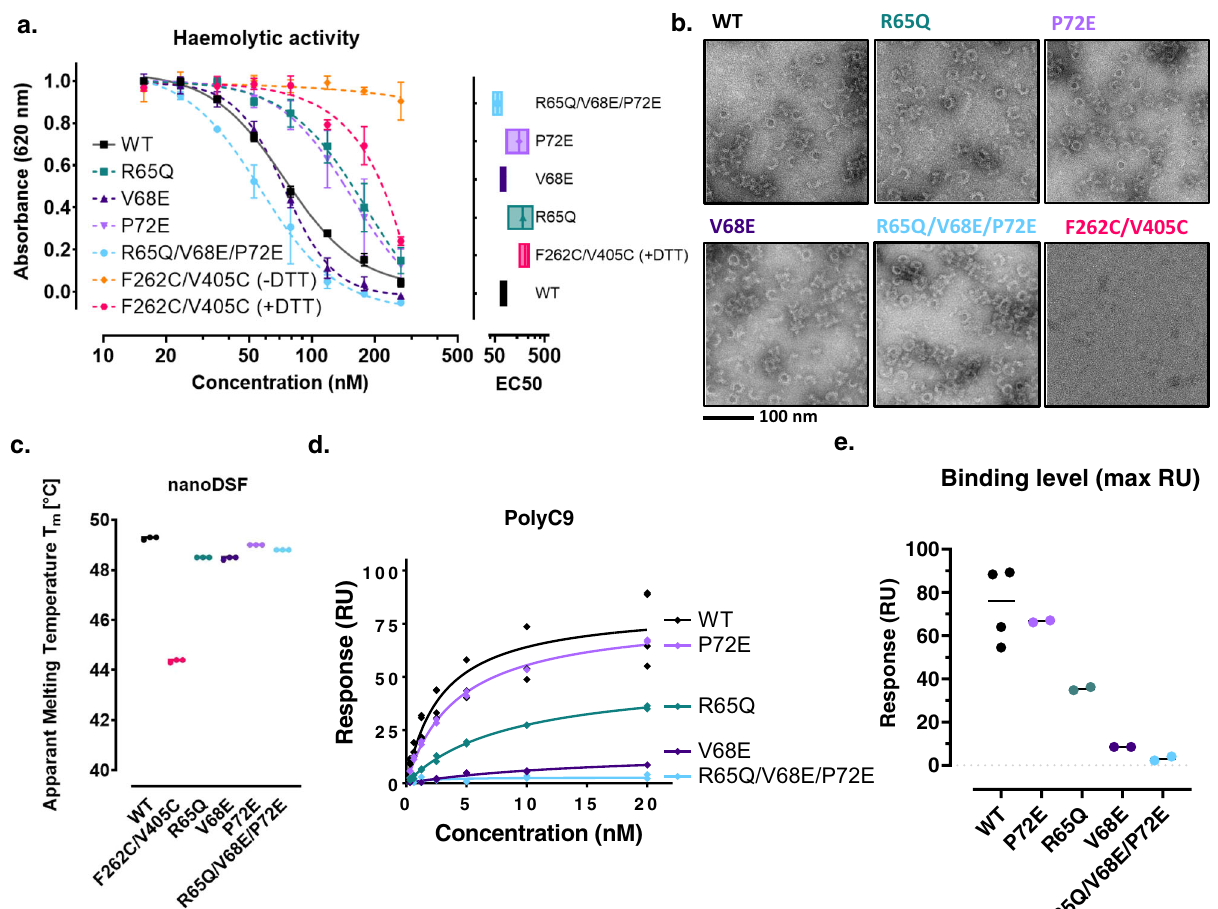
Fig. 3 Characterisation of the C9 neoepitope by site-directed mutagenesis and SPR. a Concentration series and effective half-maximal concentration of MAC haemolytic assay with C9 variants ( n = 3; mean and standard error of the mean [SEM] are plotted). b Negative-staining electron microscopy of polyC9 variants. c Nano-differential scanning fl uorimetry measurements of apparent thermal stability. d Maximal SPR response of aE11 IgG binding versus concentration of polyC9 and variants ( n = 2). e Maximal binding of aE11 IgG (arbitrary response units) at 20 nM of polyC9 and variants ( n = 2). Individual data points and their means are